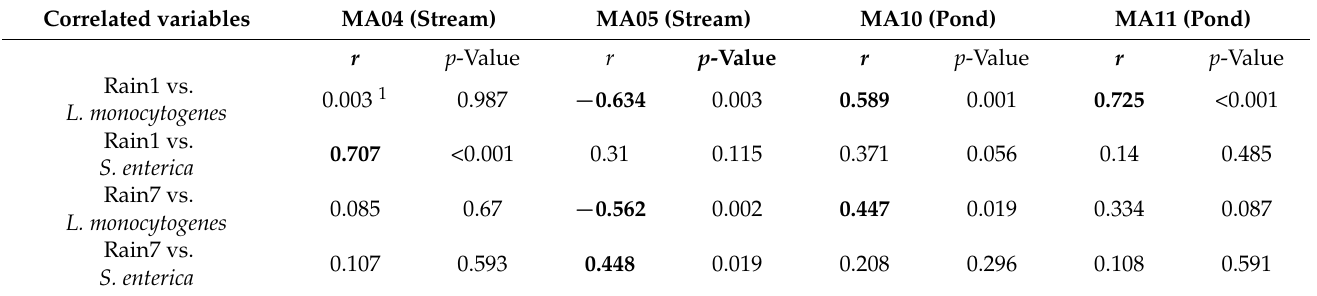
Table 2. The biserial correlation coefficient ( r ) for the relationship between cumulative rainfall data (one-day rainfall, Rain1, and seven-day rainfall, Rain7) and the prevalence of pathogens at each site.